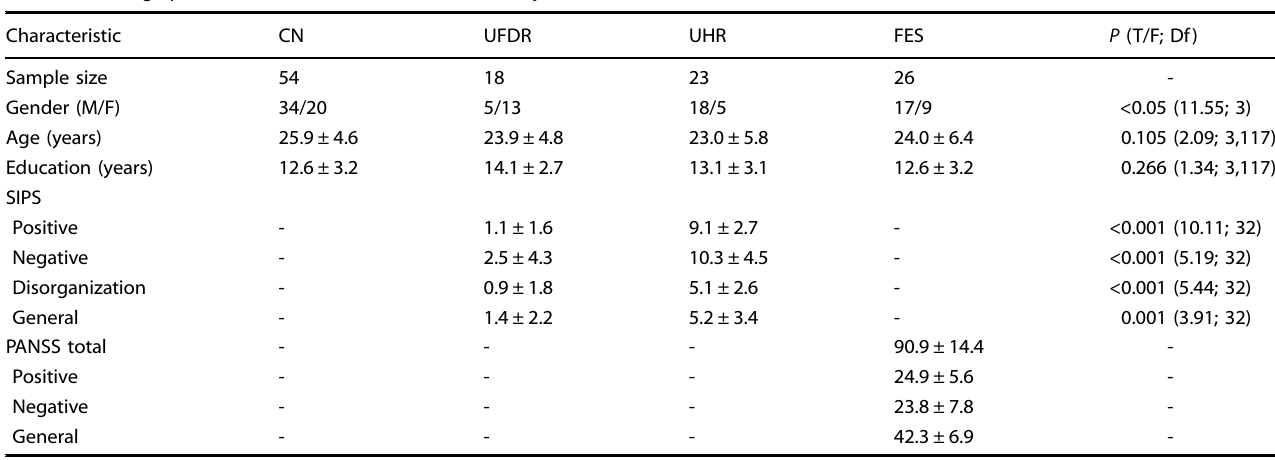
Table 1. Demographic and clinical characteristics of the